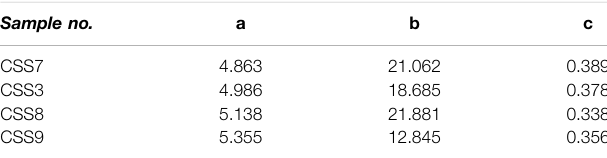
TABLE 4 | Parameters of the Fredlund-Xing model fi tting the SWCCs of calcareous silty sands with different dry densities. Sample no.